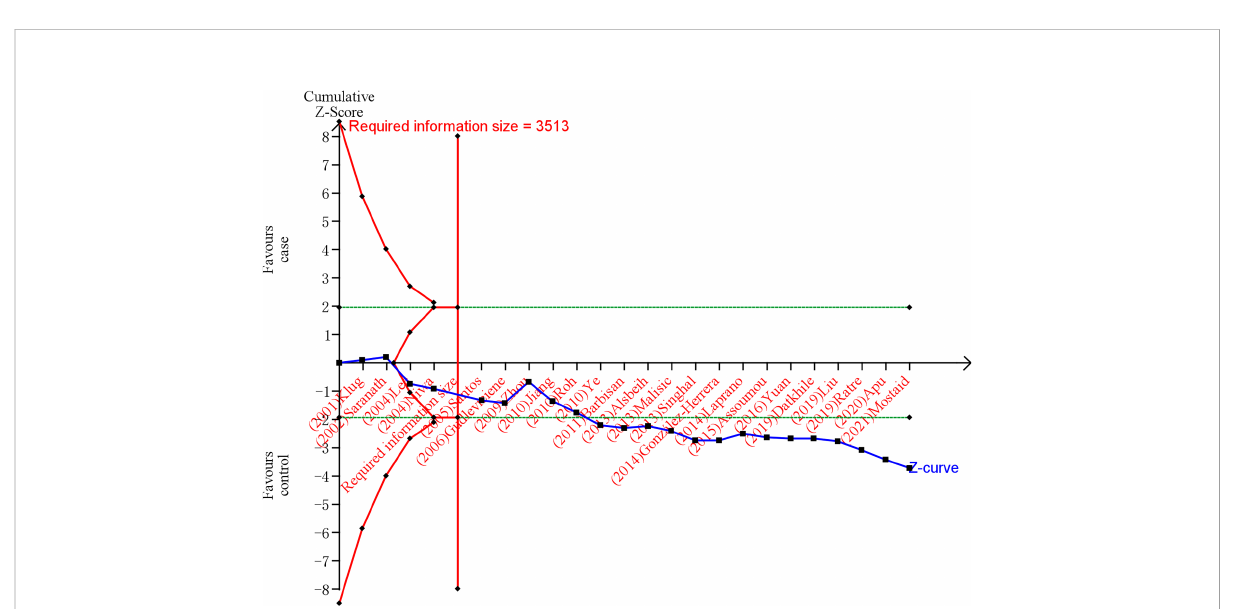
FIGURE 6 Estimation of the sample size for the relationship between TP53 rs1042522 polymorphism and cervical cancer. Trial sequential analysis (TSA) is a methodology that includes a sample size calculation for a meta-analysis with the threshold of statistical signi fi cance. We performed a TSA using an allele model assumption but replaced the allele count with the sample size (divided by 2). Detailed settings: Signi fi cance level = 0.05; power = 0.80; ratio of controls to cases = 1; hypothetical proportion of effect allele in control = 0.46; least extreme OR to be detected = 1.3; I 2 (heterogeneity) =